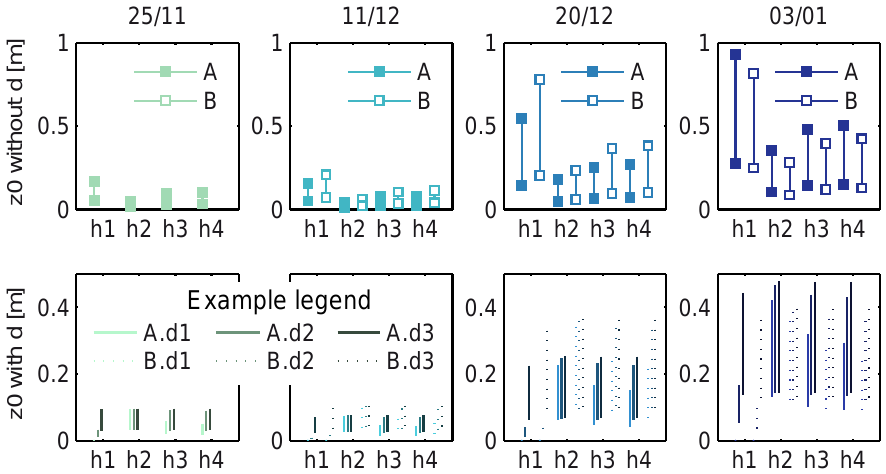
Figure 8. Comparison of three-dimensional surface roughness through time, indicating the range of z 0 computed for all incident wind angles (at 10 ◦ intervals). Upper panels show the roughness with no zero level displacement and lower panels show values with a zero displacement offset d1 = h ; d2 = 2 / 3 h and d3 = 1 / 3 h . As before, h1 – h4 refer to representative surface heights computed as range, twice the standard deviation, area weighted mean height above the minimum and area weighted median above the minimum mesh height